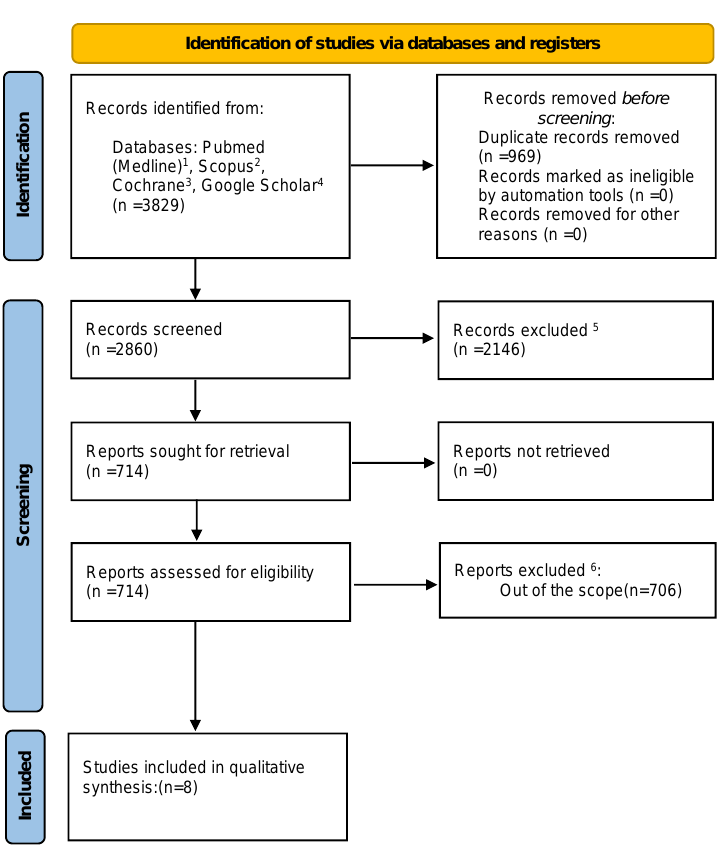
Figure 1. Flowchart of the search.